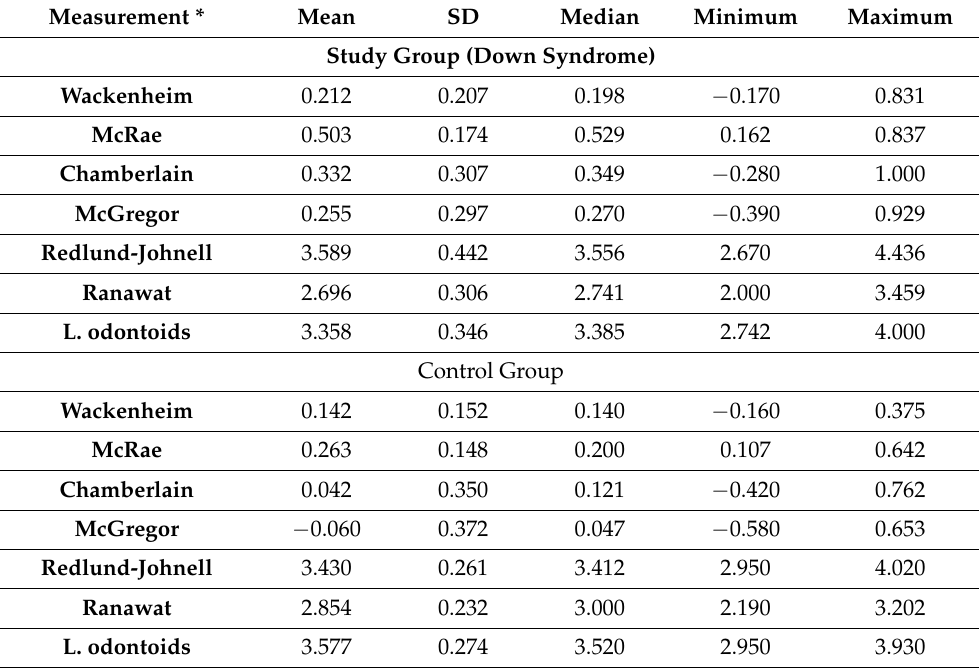
Table 2. Craniovertebral Measurements in the Study (Down Syndrome) and Control Group.